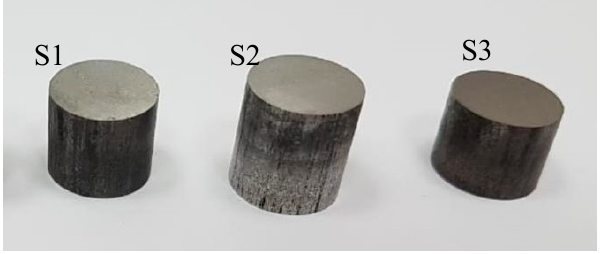
Figure 4. Set of consolidated bulk composites.